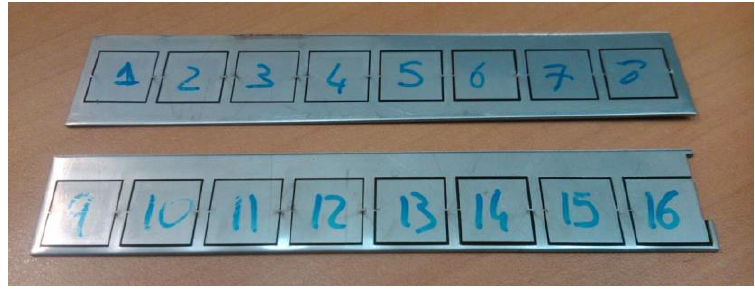
Figure 1. Laser-cut AISI 304 stainless steel specimens.